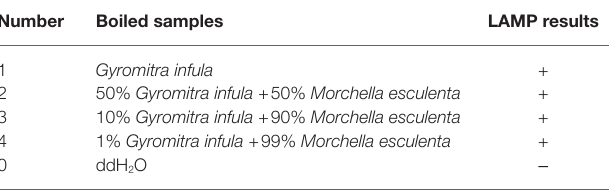
TABLE 6 | Applicability results of LAMP assay with boiled mushrooms. Number